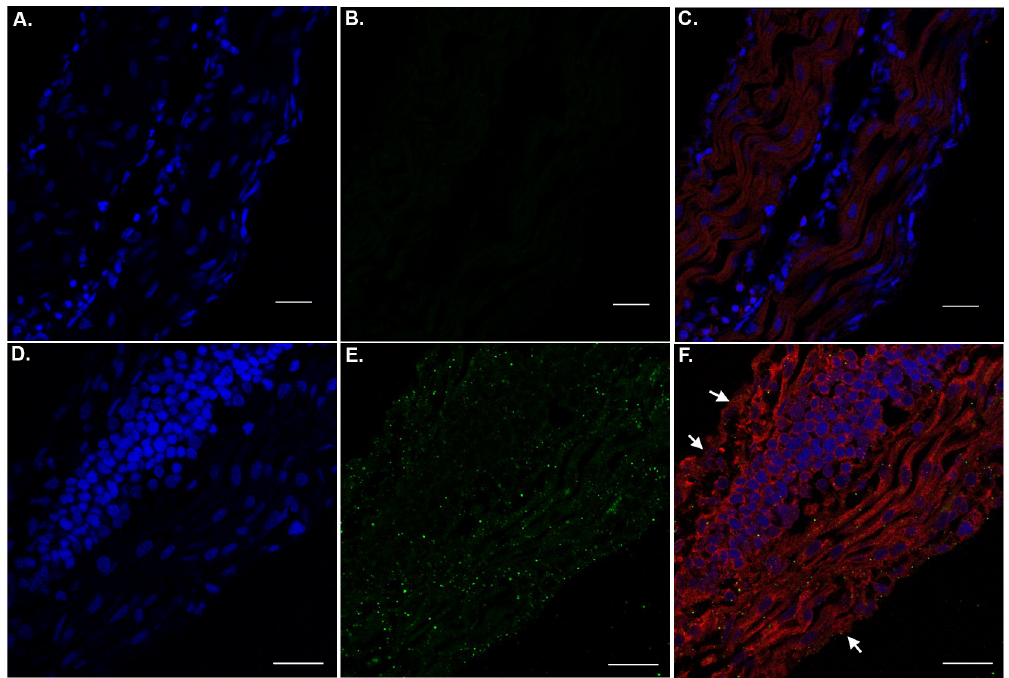
Fig 7. The presence of nApoE4 1-151 within tail regions of zebrafish embryos. A-C: Representative images from confocal immunofluorescence in 5 mm paraffin-embedded sections of non-treated control 48 hpf zebrafish embryos that were stained with DAPI (A), anti-His antibody (1:500) (B), and the merged image together with PHF-1 (1:250) in Panel (C). There was no detection of any nApoE4 1-151 fragments in untreated control sections as indicated by the lack of labeling in Panel B. D-F: Identical to Panels A-D with the exception that embryos were exogenously treated for 24 hours with 25 μ g/ml of nApoE4 1-151 . In this case punctate staining of the fragment was observed that appeared cytoplasmic. PHF-1 labeling was identified in muscle cells that exhibited abnormal morphology (arrows, Panel F). All scale bars represent 20 μ m.